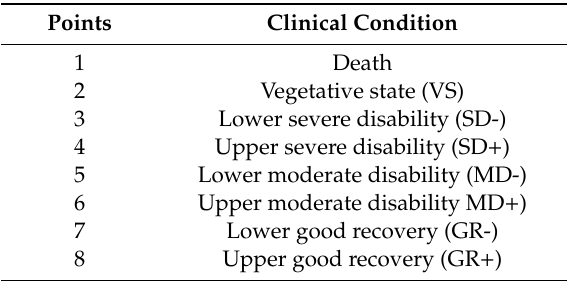
Table 1. The Extended Glasgow Outcome Score measured 6 months after TBI (traumatic brain injury).